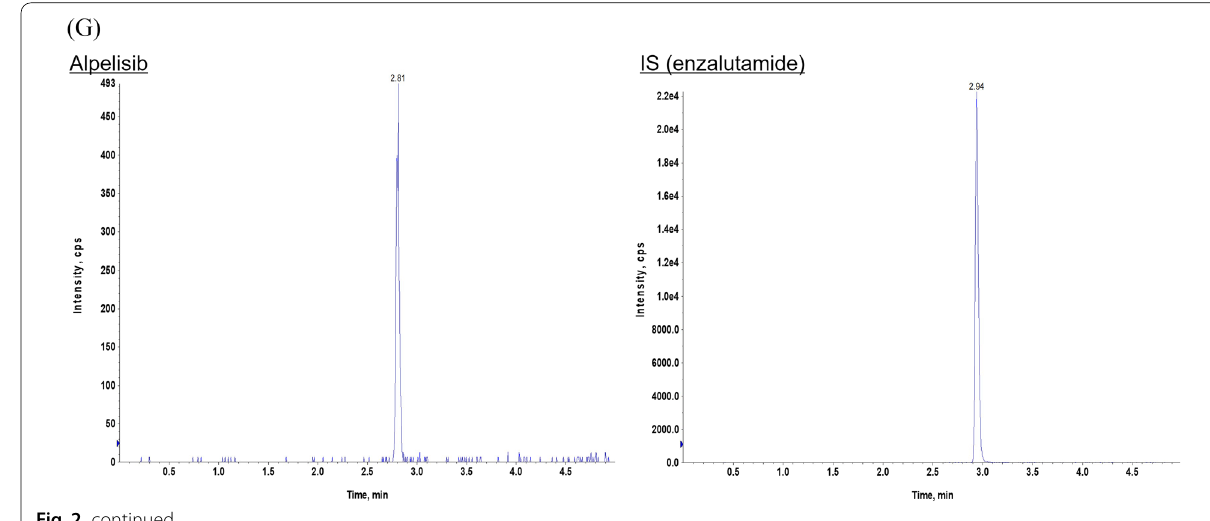
Table 1 Intra‑/inter‑day accuracy and precision of alpelisib in mouse and human plasma